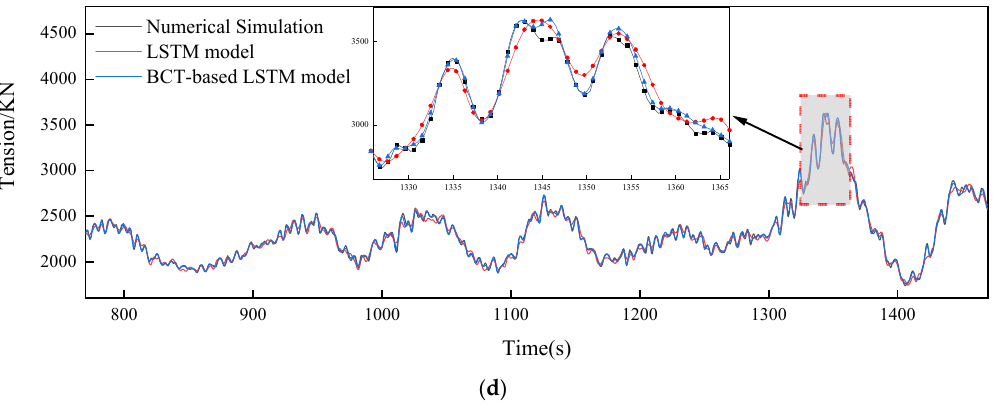
Figure 12. The comparison of prediction results under sea state 4–7. ( a ) The comparison of prediction results under sea state 4; ( b ) the comparison of prediction results under sea state 5; ( c ) the comparison of prediction results under sea state 6; and ( d ) the comparison of prediction results under sea state 7. Table 6. The statistical error of line 1 under sea states